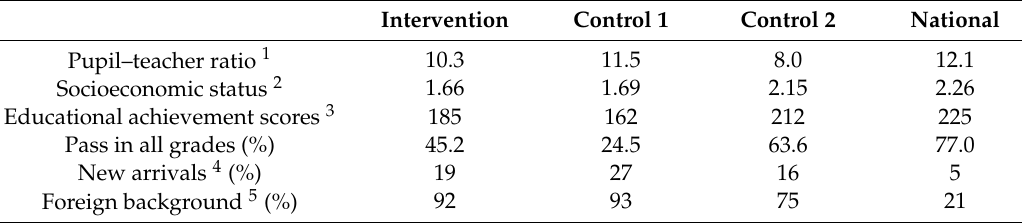
Table 1. Descriptive data for the three schools involved in the intervention at T1